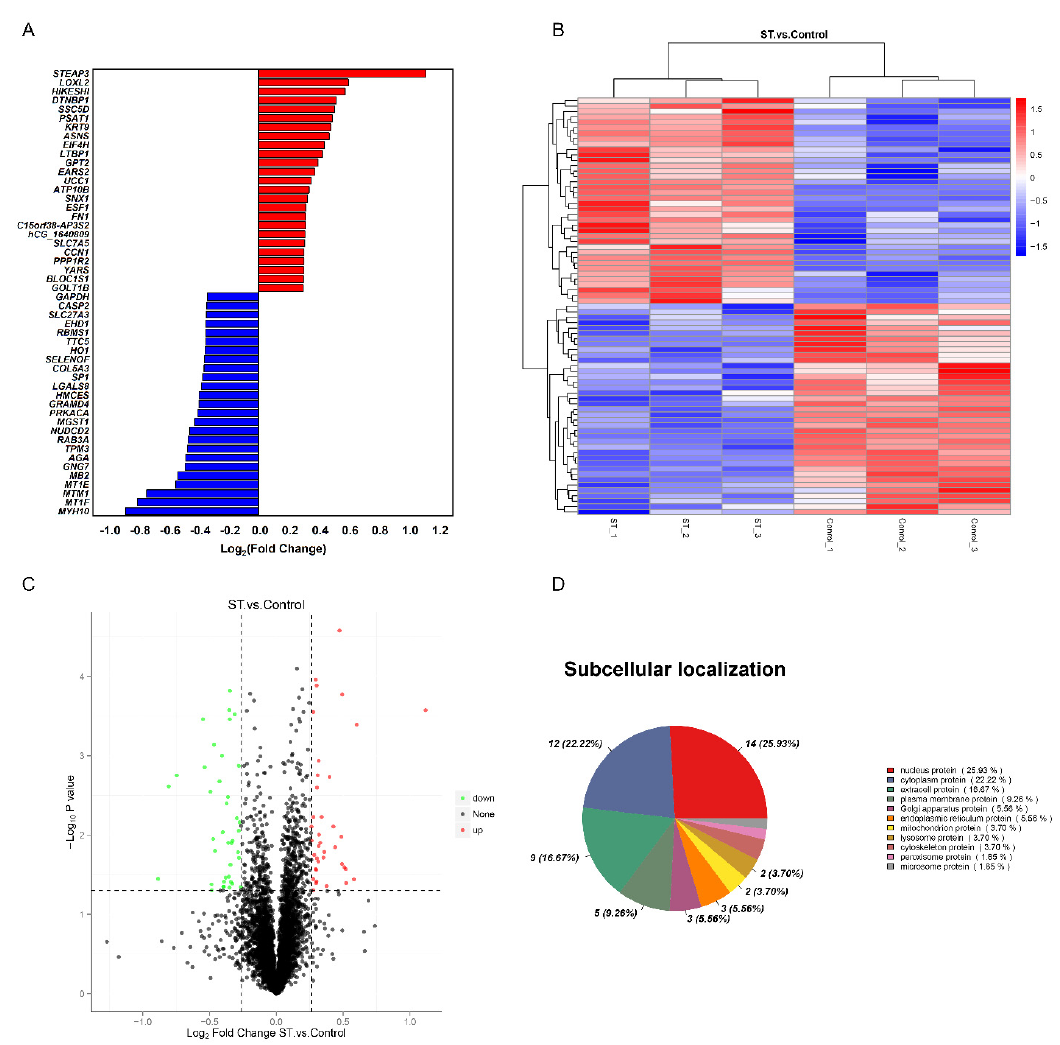
Figure 1. Comparative proteomics analysis of hNSCs in different treatments. ( A ) The top 25 upregulated and downregulated proteins in the stemazole and control groups, satisfying the criteria of fold change (FC) ≥ 1.2 or ≤ 0.83 and p value ≤ 0.05. ( B ) Clustering heatmap of the 77 proteins, in which the expression was altered in different samples. Each row represents one protein, and each column shows one biological replicate. The colour intensity indicates the relative expression level of proteins which by z − value correction. ( C ) Volcano plot distribution of proteins: 38 upregulated (red dots) and 39 downregulated (green dots) proteins in the stemazole − treated cells compared to the control cells. ( D ) Subcellular localization of differentially expressed proteins analysed by the Cell − mPLOC 2.0